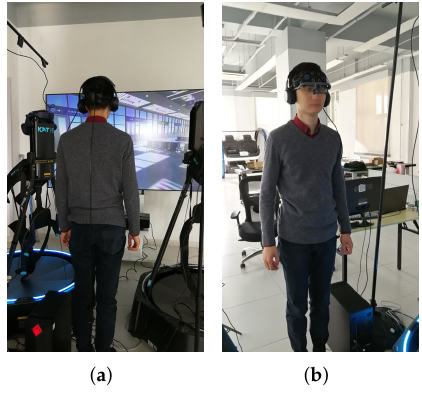
Figure 5. Setup example. ( a ) Back, ( b )